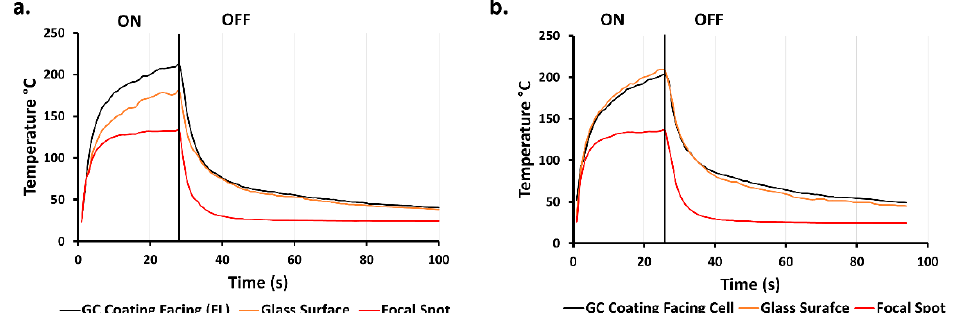
Figure 5. GC 2.2 sample ( a ) facing the source of solar irradiance and ( b ) meeting the polycrystalline cell.